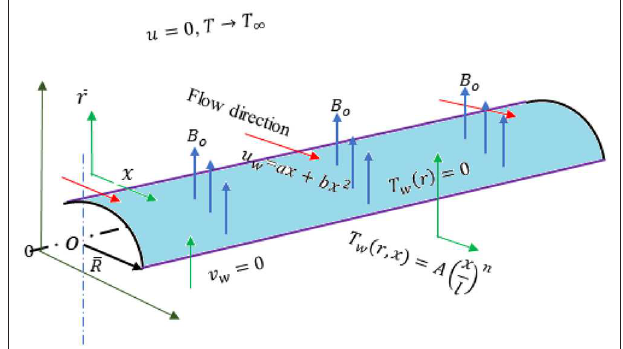
FIGURE 1 | Physical geometry of the